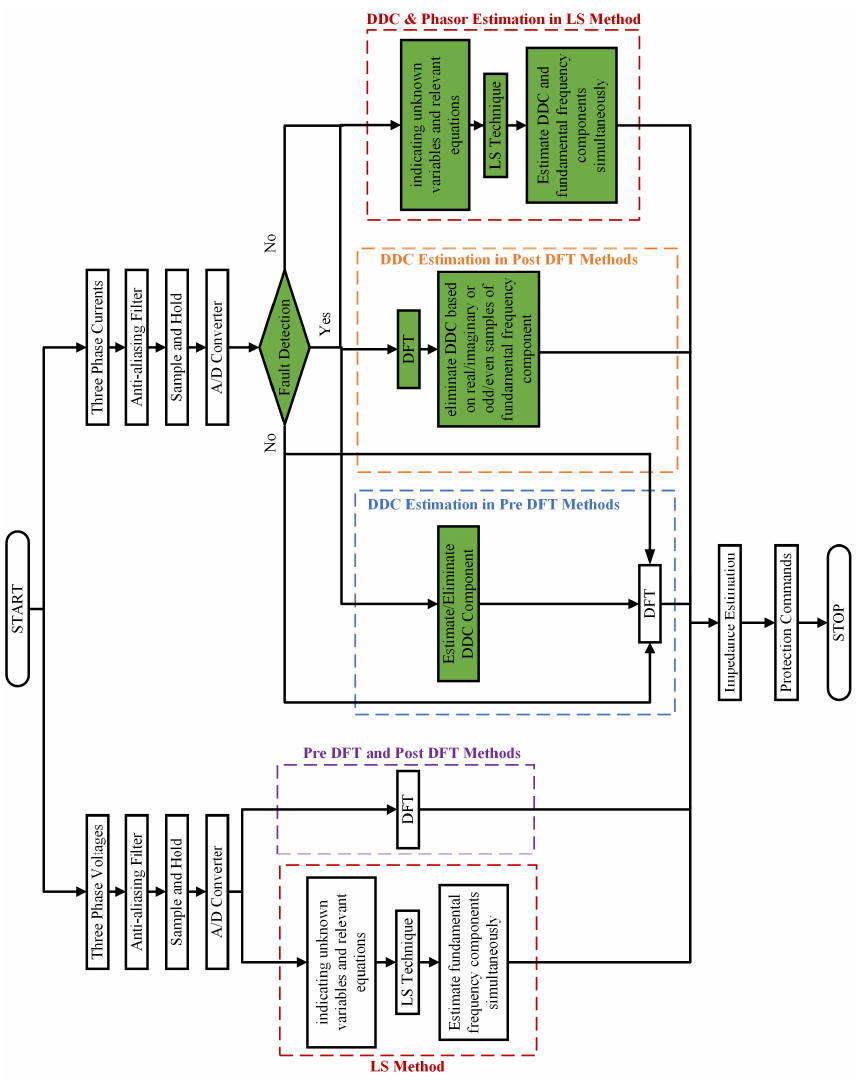
Figure 6. General flowchart of DDC mitigation methods: pre-DFT, post-DFT, and LS-based